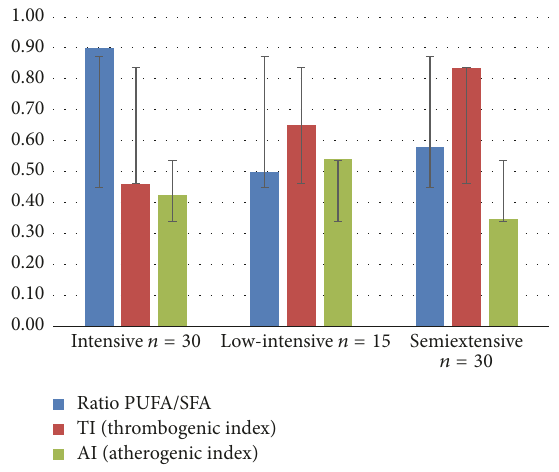
Figure 2: Selected parameters of fatty acid profile of carp muscle tissue under study